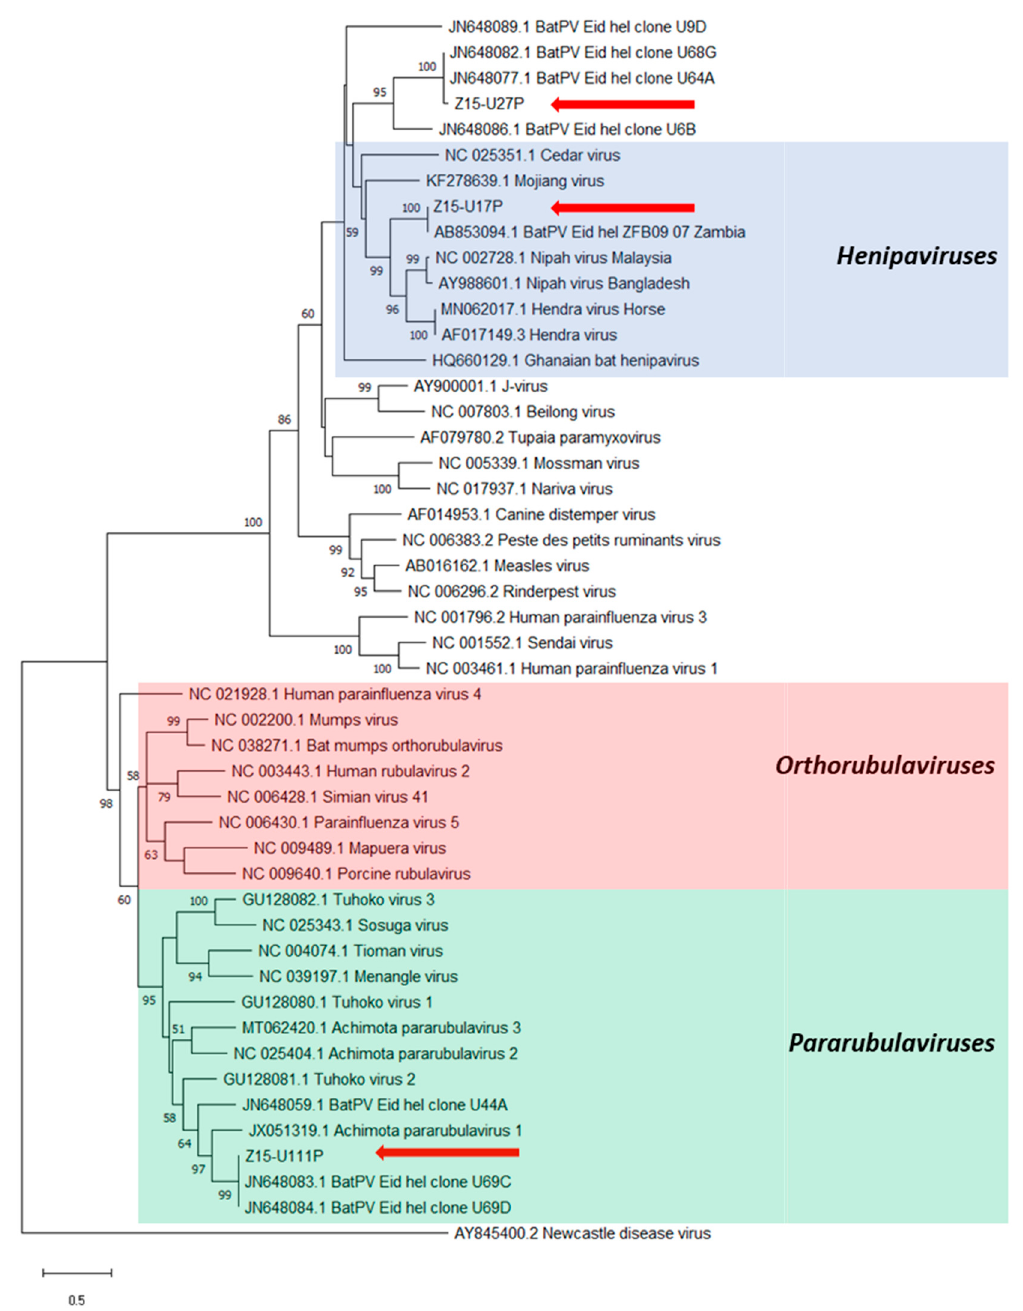
Figure 3. Phylogenetic analysis of partial L gene sequences obtained after PAR-PCR on E. helvum urine samples (red arrows). Maximum likelihood tree with bootstrapping (1000 iterations) generated in MEGA X, using 530 bp alignment against publicly available paramyxovirus sequences (NCBI Genbank) and outgroup Newcastle disease virus. Bootstrap values for 1000 replicates are indicated as percentages (where >50%) and the number of nucleotide substitutions per site is to scale as indicated by the scale bar.